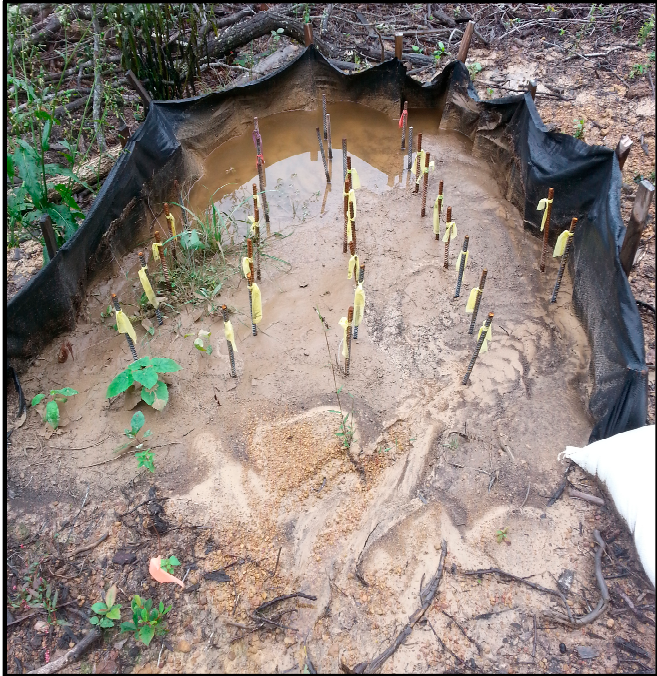
Figure 4. An example of the silt fence sediment traps used in the study. Sediment pins were driven into trap area on a grid pattern and measured at regular